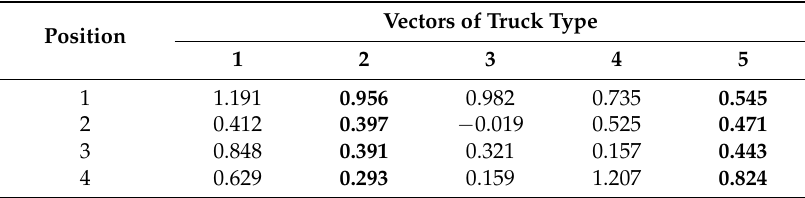
Table 13. Vectors after mutation of vector positions of truck type.